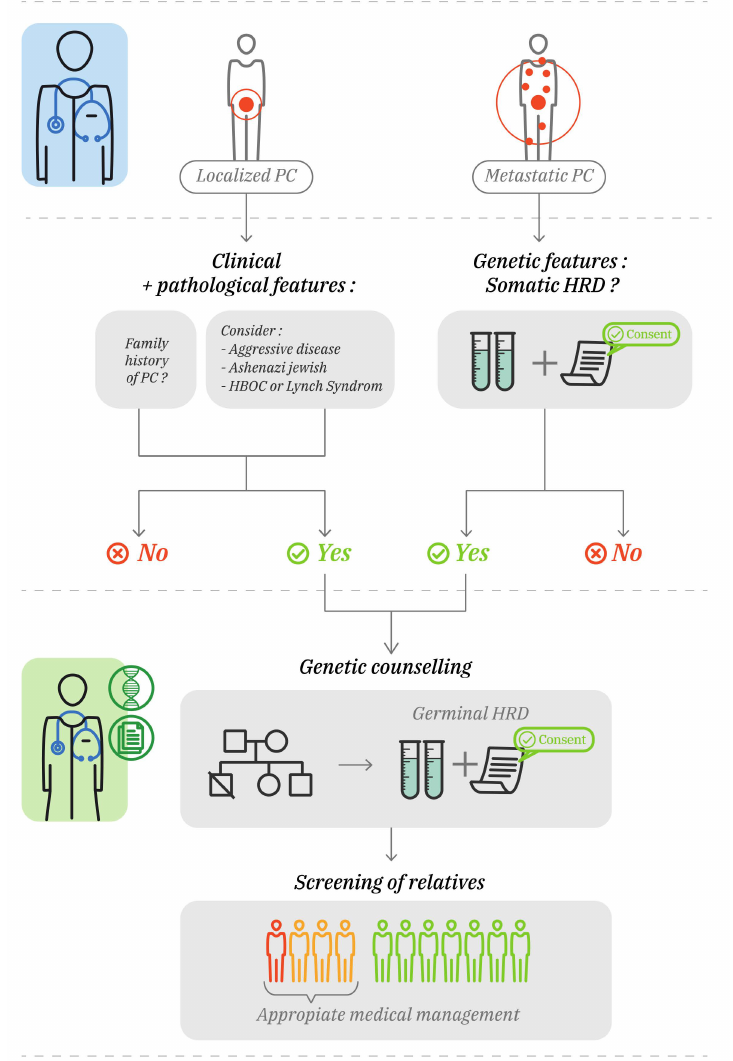
Figure 2. Genetic counselling place for prostate cancer. Localized prostate cancer (PCa)